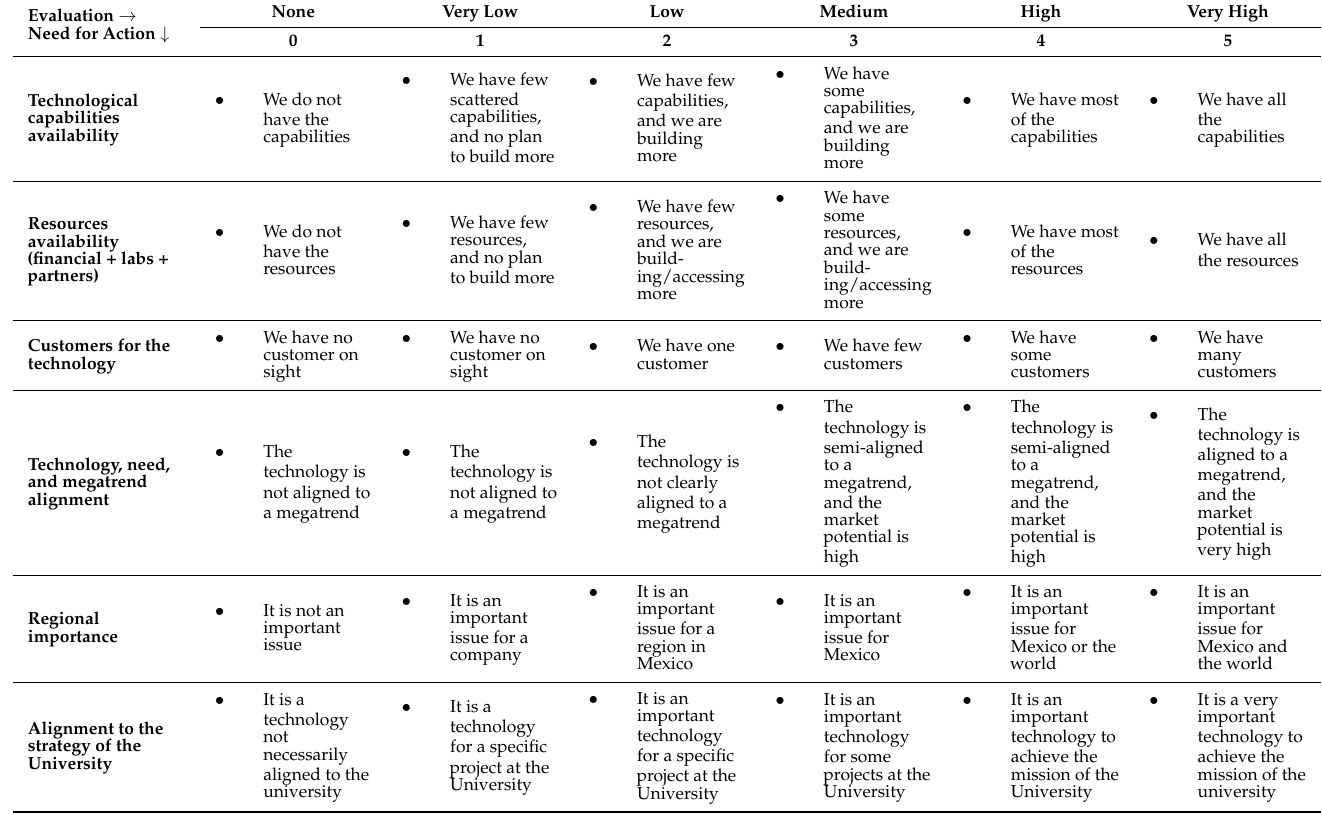
Table 5. Need for action